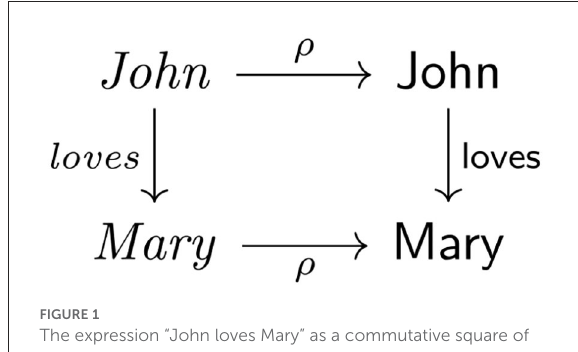
FIGURE1 The expression “John loves Mary” as a commutative square of arrows.